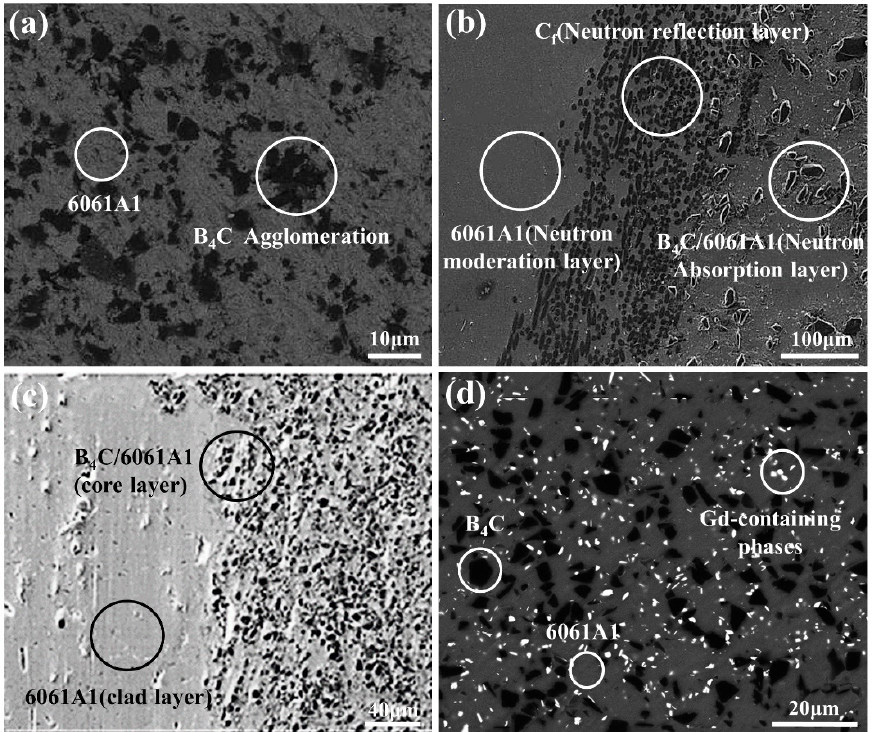
Figure 11. Microstructure of ( a ) 30 wt% B 4 C/6061A1 [57], ( b ) (B 4 C + 6061Al)/C f /6061Al [16], ( c ) 6061Al/(B 4 C + 6061Al)/6061Al [58], and ( d ) (1 wt% Gd + 15 wt% B 4 C)/6061Al [59].